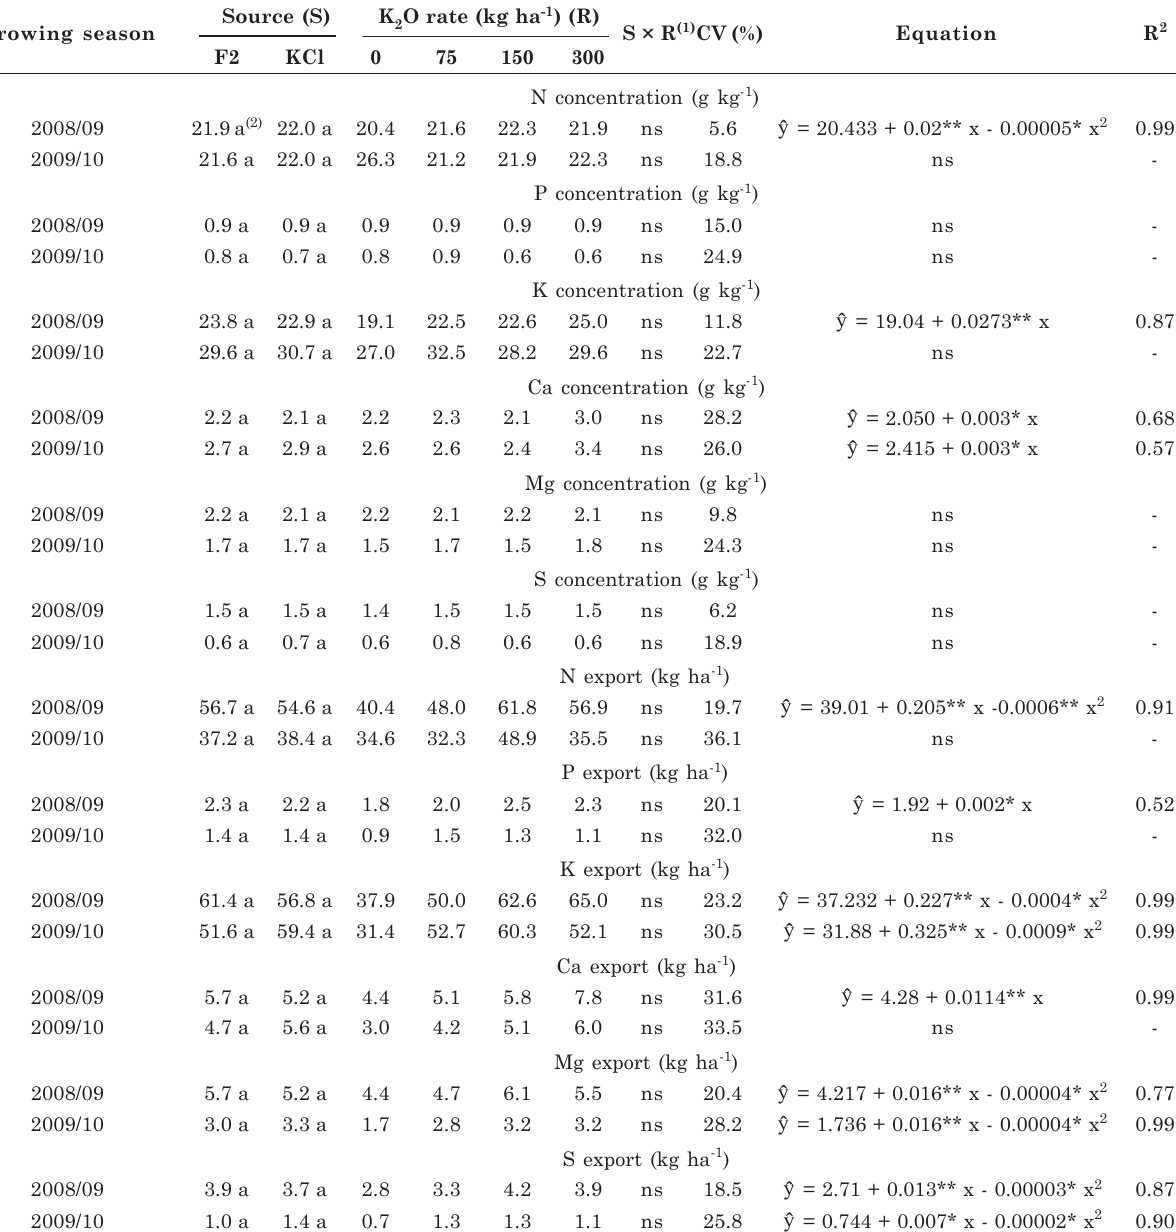
Table 4. Effect of sources and rates of potassium fertilization on concentration and export of N, P, K, Ca, Mg, and S in air-dried fruit of Arabica coffee Growing